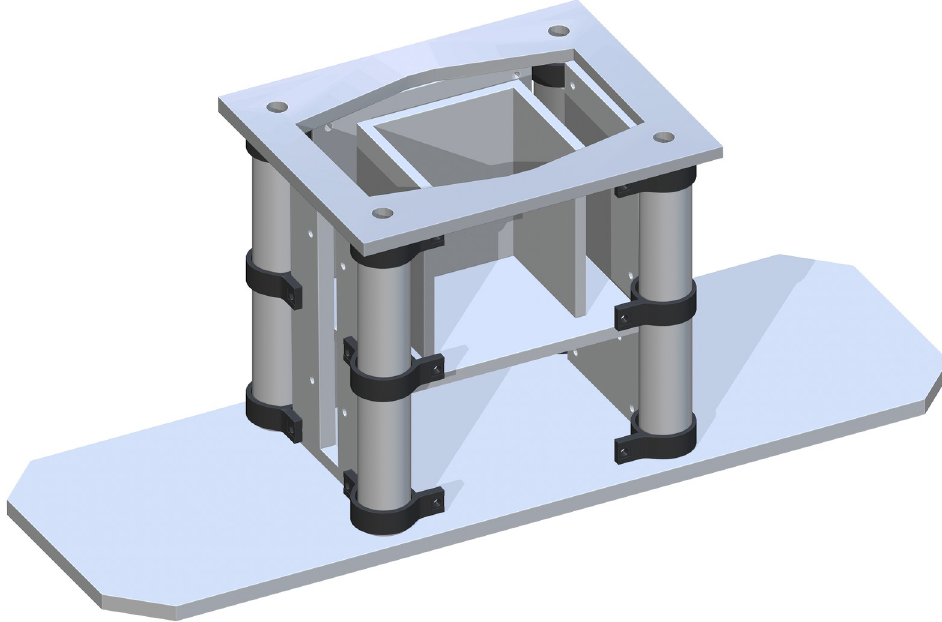
Fig 6. Addition of one side Jack insert.